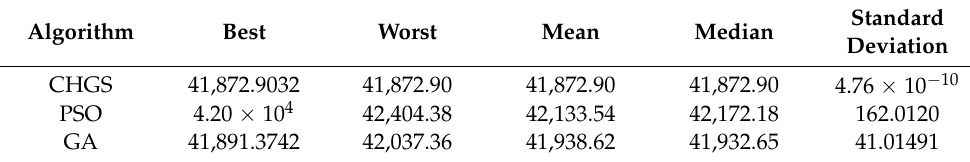
Table 5. Statistical measures of the results of the IEEE 57-bus system obtained with different algo- rithms over 20 independent runs.